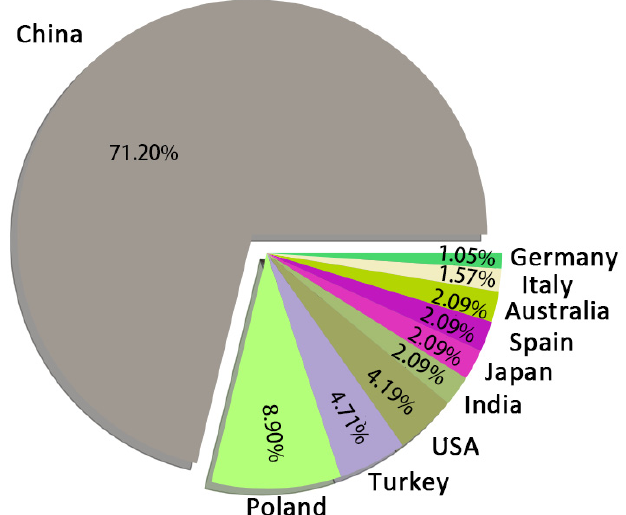
Figure 7. Pie chart of papers related to flame-retardant RPUF contributed by different countries.